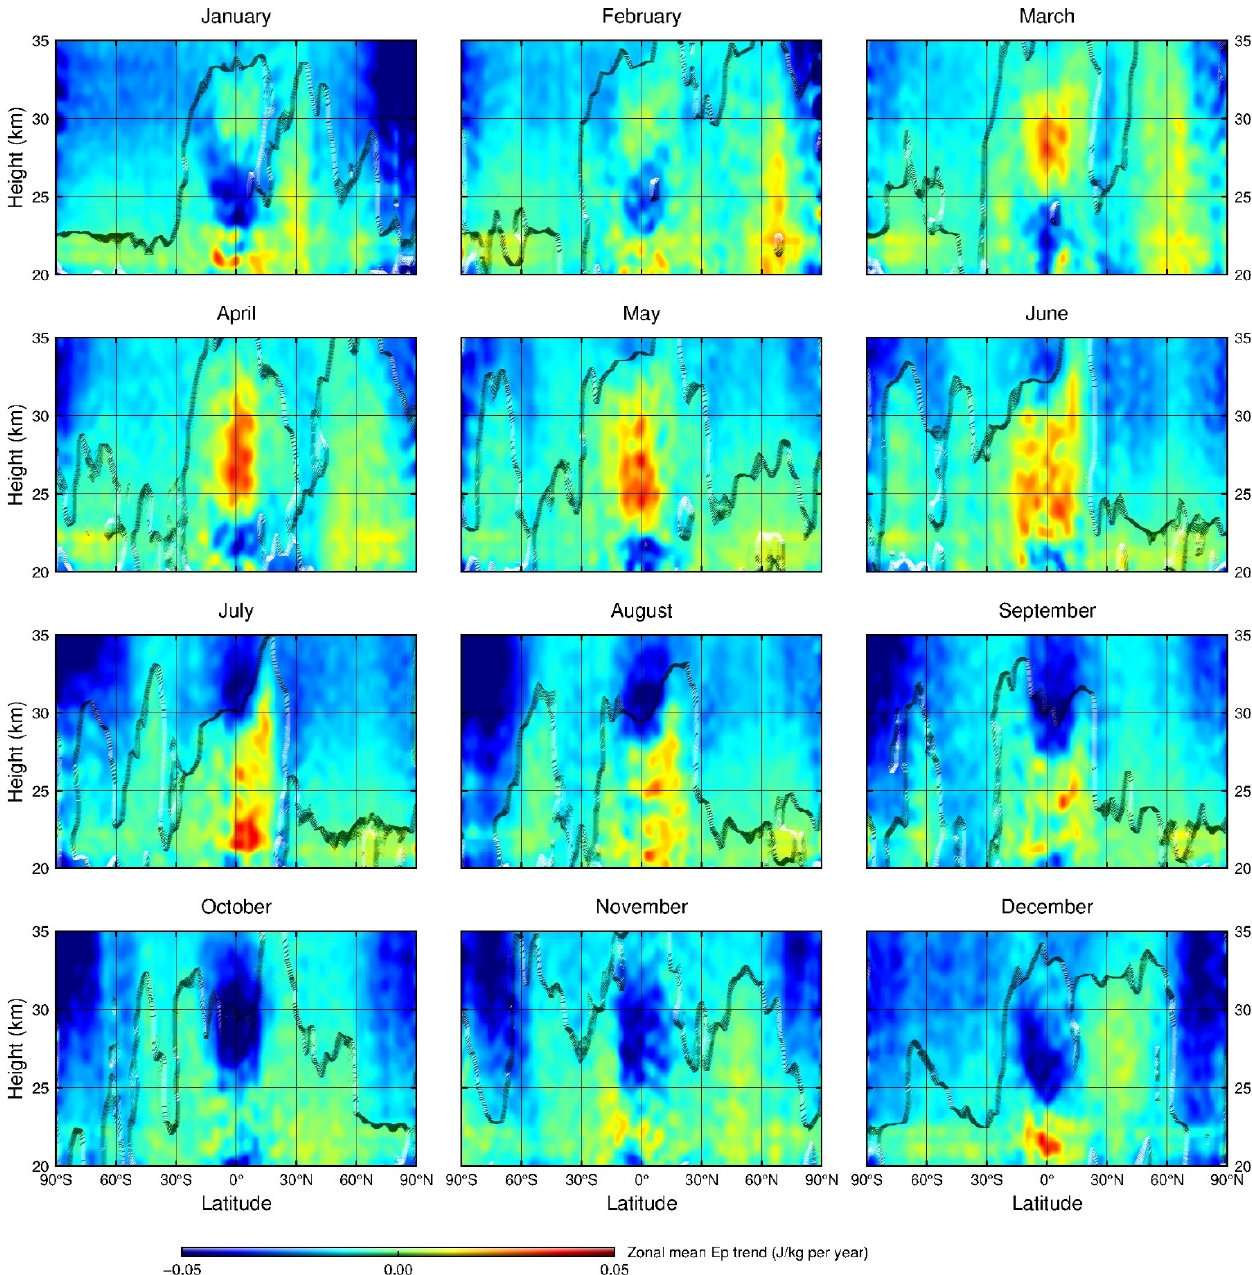
Figure 8. Latitude–height distributions of the linear trends in the monthly zonal-mean GW Ep at 20–35 km for each month during 2007 to 2020. The regions where the trends are statistically significant at the confidence level of 90% are shown as protuberance.